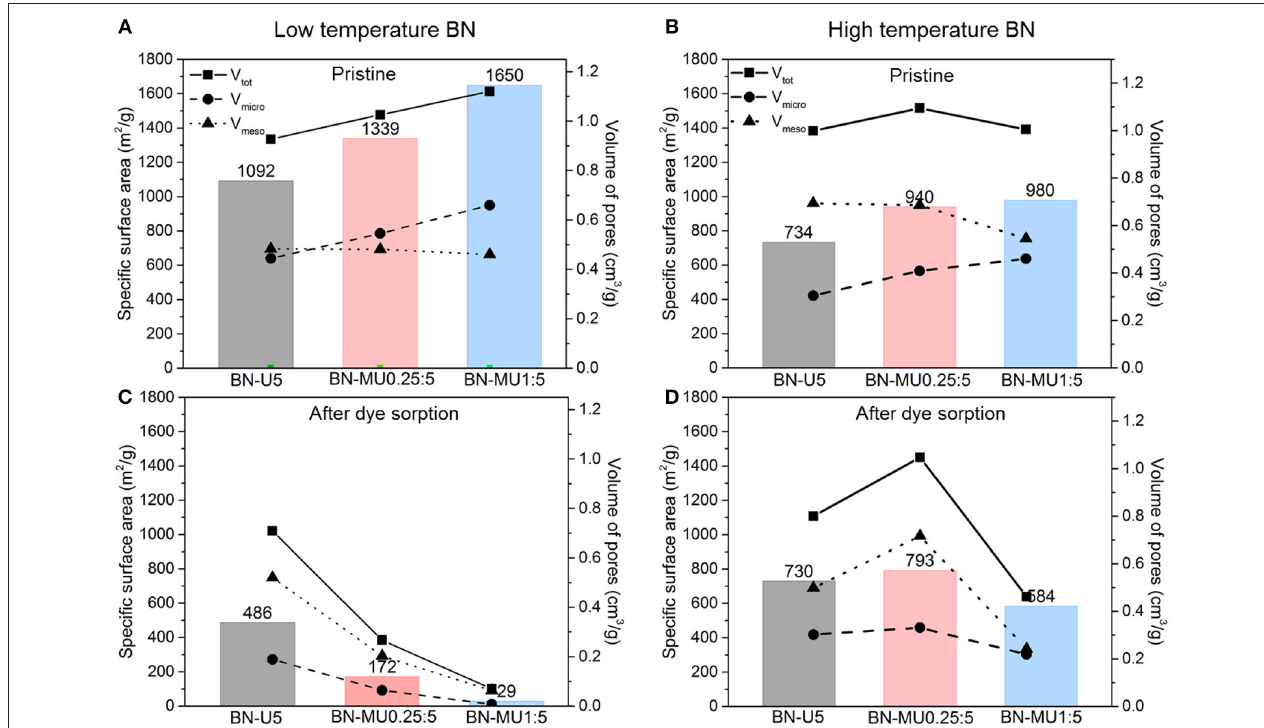
FIGURE 3 | Changes in the porosity of the BN samples upon adsorption and regeneration at 600 ◦ C in air. Textural parameters derived from N 2 sorption isotherms at − 196 ◦ C for porous BN samples: (A) synthesized at low temperature, (B) synthesized at high temperature, (C) synthesized at low temperature after dye sorption and regeneration, (D) synthesized at high temperature after dye sorption and